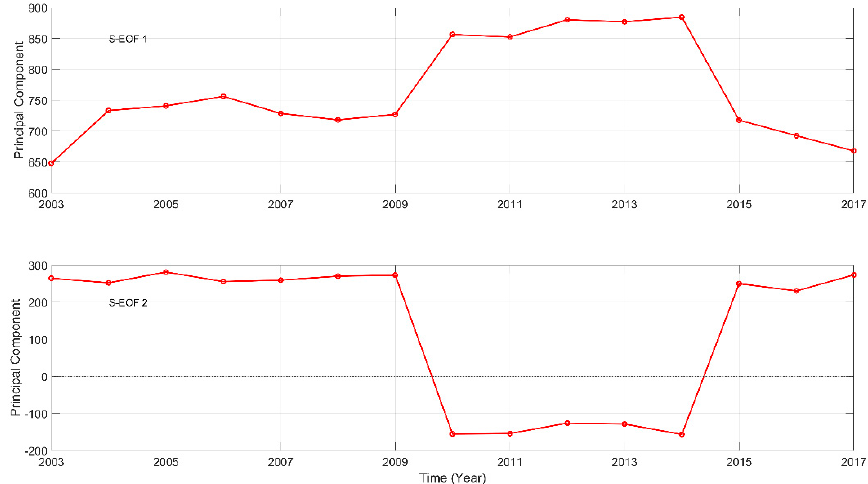
Figure 6. Principal components (PCs) of the first three S-EOF modes of K d (490) in the PRE waters.